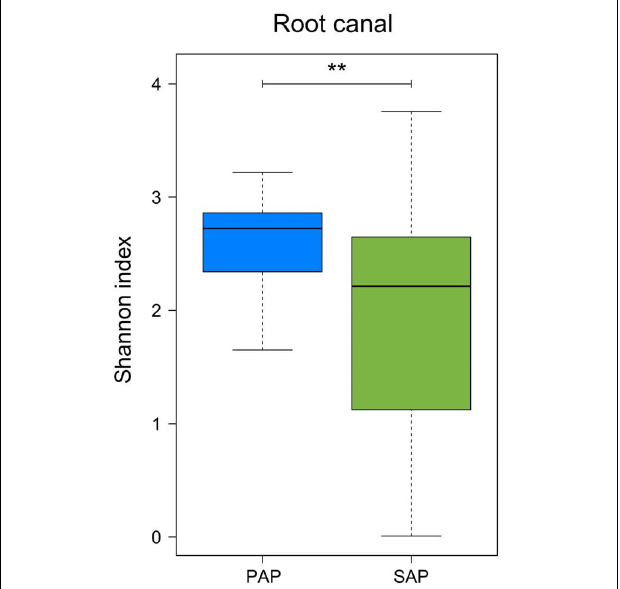
FIGURE 4 | Alpha diversity of the microbiota from root canal of PAP and SAP teeth. Shannon diversity index was based on OTU relative abundance. ∗∗ 0.001 < P < 0.01. PAP, primary apical periodontitis; SAP, secondary apical periodontitis.